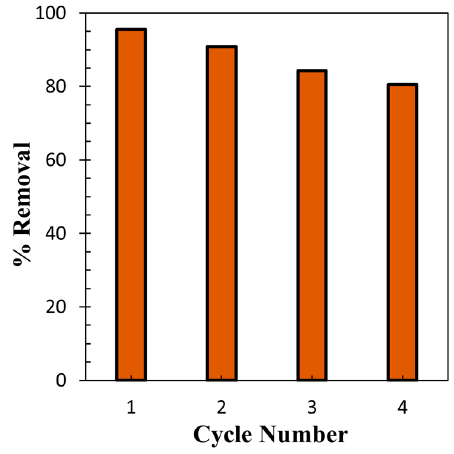
Figure 17. Recycling performance of rGO for capturing of MB up to 4 cycles ( C MB0 = 20 mg/L, W rGO = 8 mg, V = 100 mL, T = 298 K).